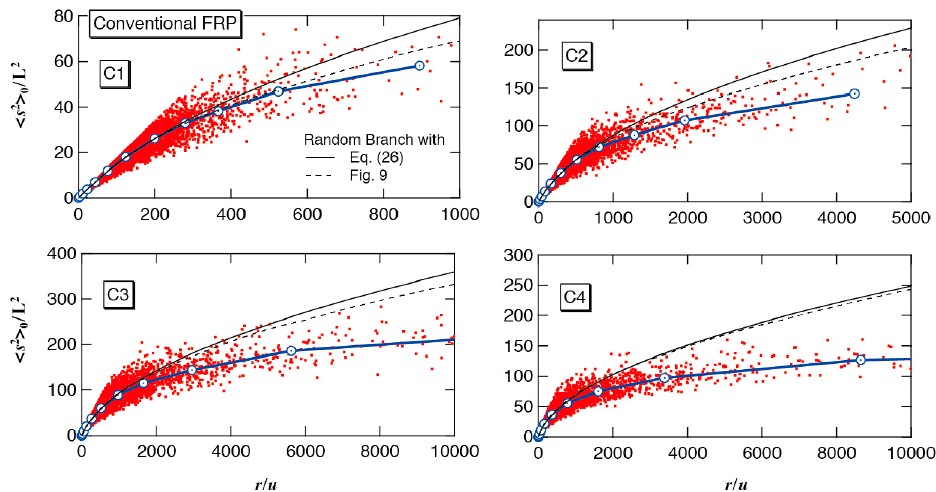
Figure 13. Relationship between the mean-square radius of gyration, < s 2 > 0 and the chain length, r for the conventional emulsion polymerization conditions, C1–C4. The red dots show the property of each polymer molecule simulated, and the blue curve with circular symbols is the expected < s 2 > 0 –value for the given r . The black solid and dotted curves are for the random branched polymers, having the same primary chain length distribution. See more details in the text.